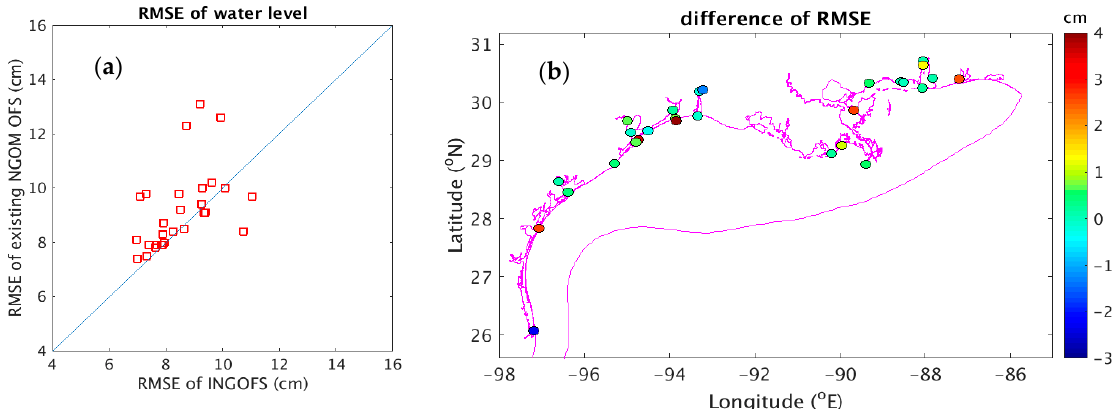
Figure 19. Comparison of the water level skill between the INGOFS and the NGOFS, ( a ) scatter plot of RMSE and ( b ) the RMSE difference between INGOFS and NGOFS.